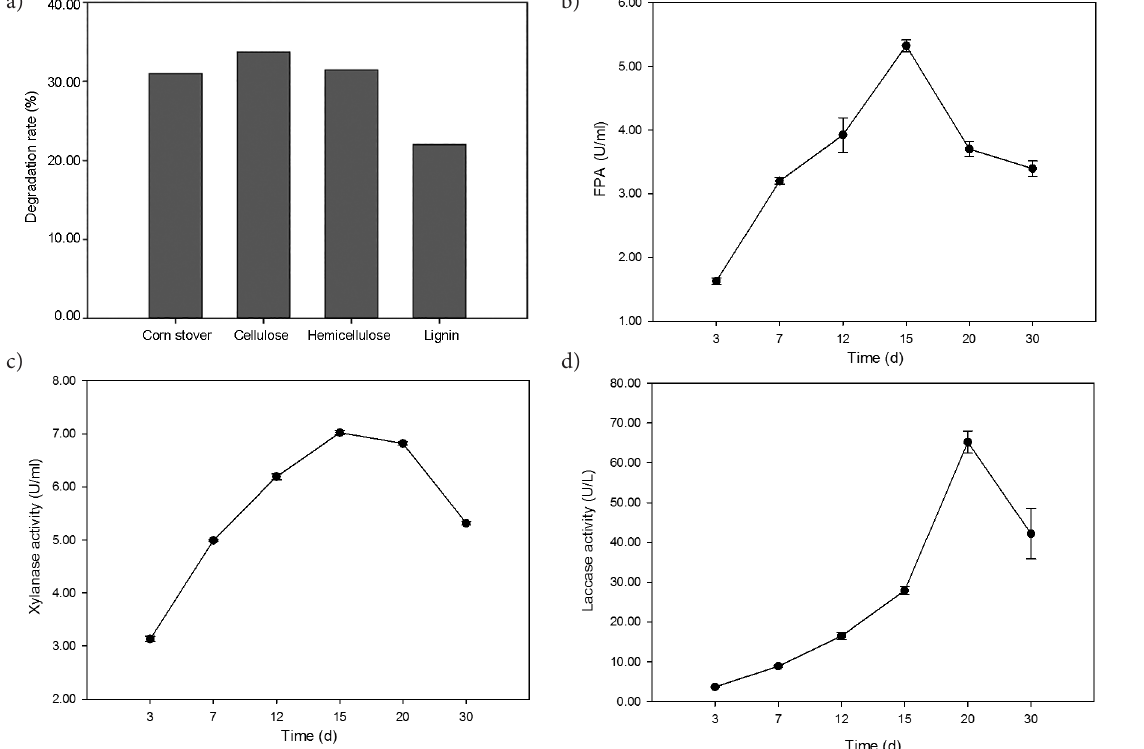
Figure 1. Degradation of characteristics of corn stover